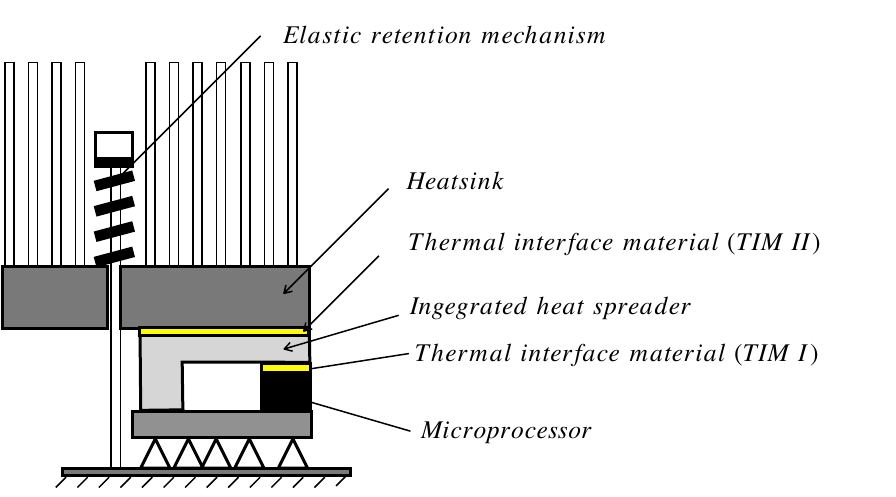
Figure 23. Possible microelectronic packaging architecture for high-generation